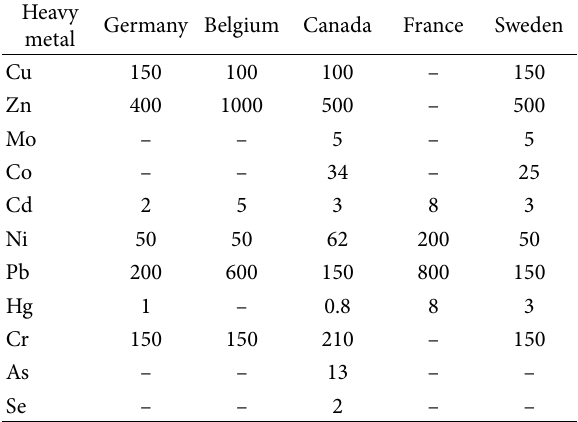
Table 1. Maximum permissible limits stipulated by various countries for the heavy metal content of composts (mg/kg dry compost)